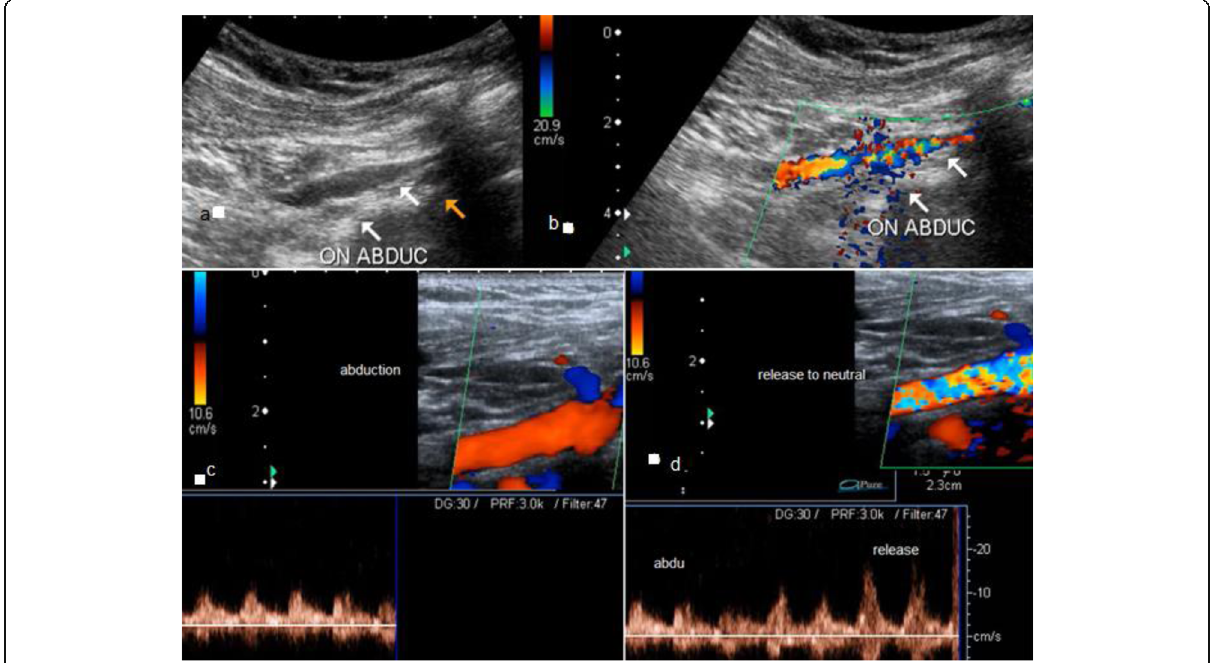
Fig. 3 a B-mode image of the axillary-subclavian artery junction showing tapered significant narrowing of the axillary artery on arm abduction (white arrows) at the outlet of the costo-clavicular space (yellow arrow). b Color image for the same arterial segment in ( a ) showing marked color aliasing with a visible bruit due to high velocity jet of the arterial stenosis (white arrows). c Spectral and color Doppler image for the downstream brachial artery showing significant dampening of the flow on arm abduction. d Spectral and color Doppler image showing rebound hyperemia (color aliasing) with increased velocity on release of the impingement of the artery by return to the neutral arm